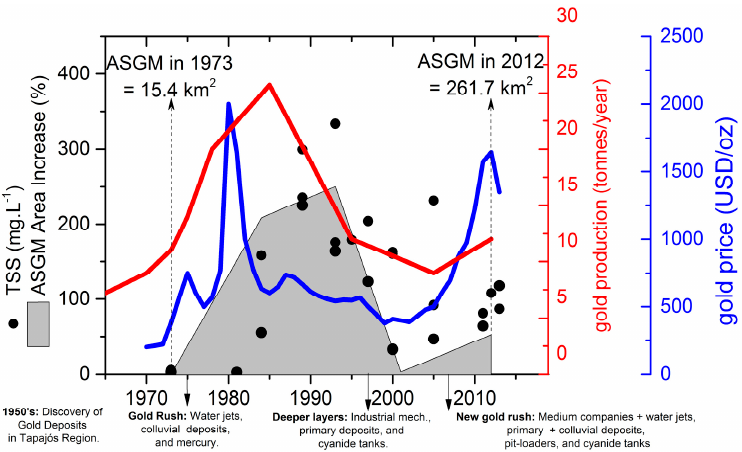
Figure 13. Plot of the percentage ASGM for the whole study area, along with the TSS concentration at the Crepori and Tocantins rivers, gold production in tonnes/year [4] in the Tapajós Area, and gold price (USD/oz) adjusted for inflation from 1970 to 2013 [34]. Chronological events of mining techniques, type of gold deposits exploited and type of miners are indicated by the arrows. Adapted from [12] .